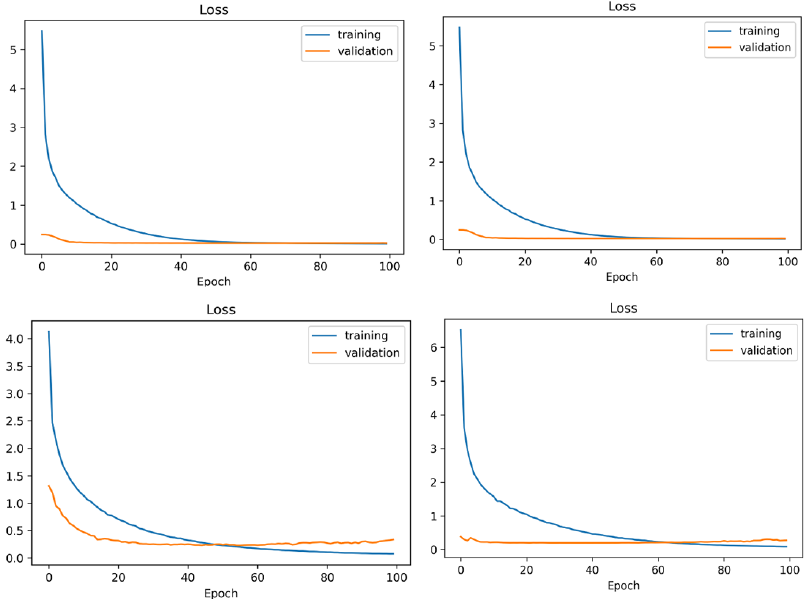
Figure 7. Loss metrics: ( Top left ) steering angle and ( Top right ) speed. Loss metrics: ( Bottom right ) steering angle and ( Bottom left ) speed.